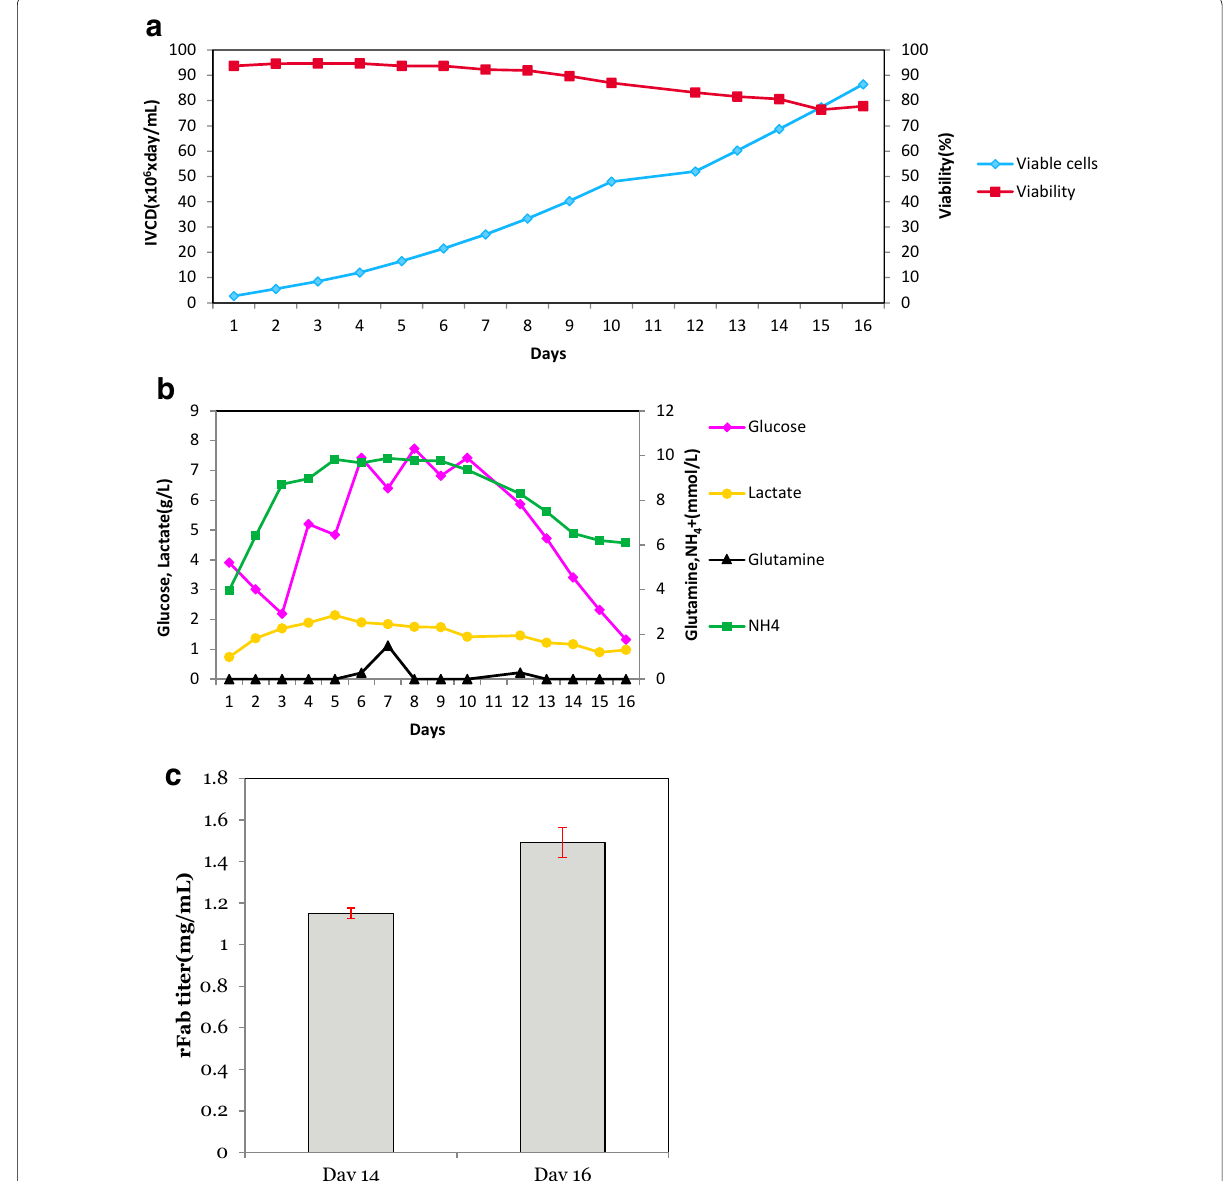
Fig. 7 a Integrated viable cell density and cell viability of CHO cells in the 5 L bioreactor over the 16-day growth period. b Glucose, lactate, glutamine, and ammonium concentrations during the 16-day growth period in the 5 L bioreactor. c rFab titers from the 5 L bioreactor determined at day 14 and day 16 when growth was